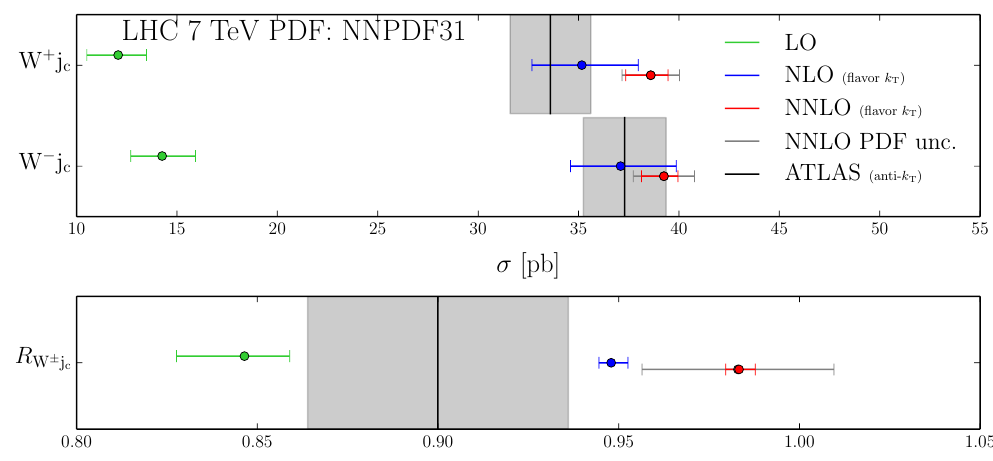
at the , pp → W − j , and the ratio R W ± j c c c